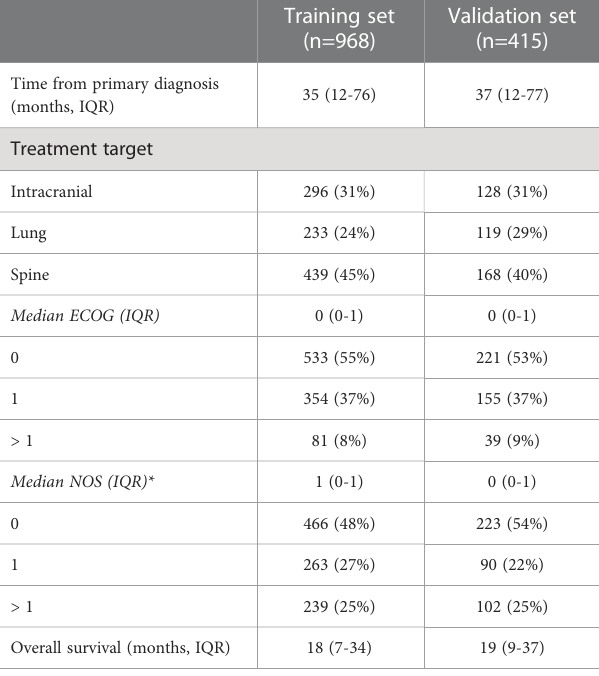
TABLE 1 Patient characteristics utilized for recursive partitioning analysis are demonstrated, as divided into training and validation